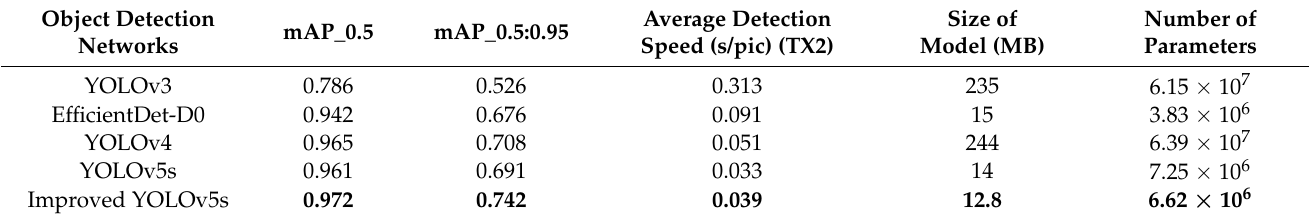
Table 3. Performance comparison of four object detection networks.